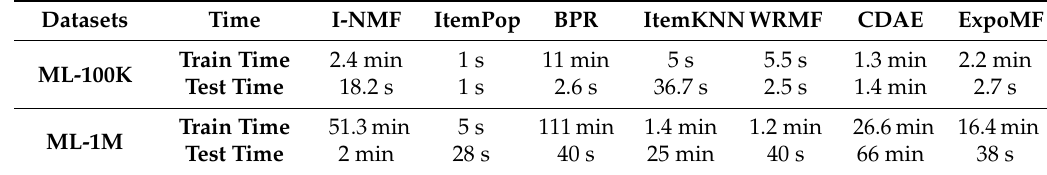
Table 6. Running time of I-NMF and comparison